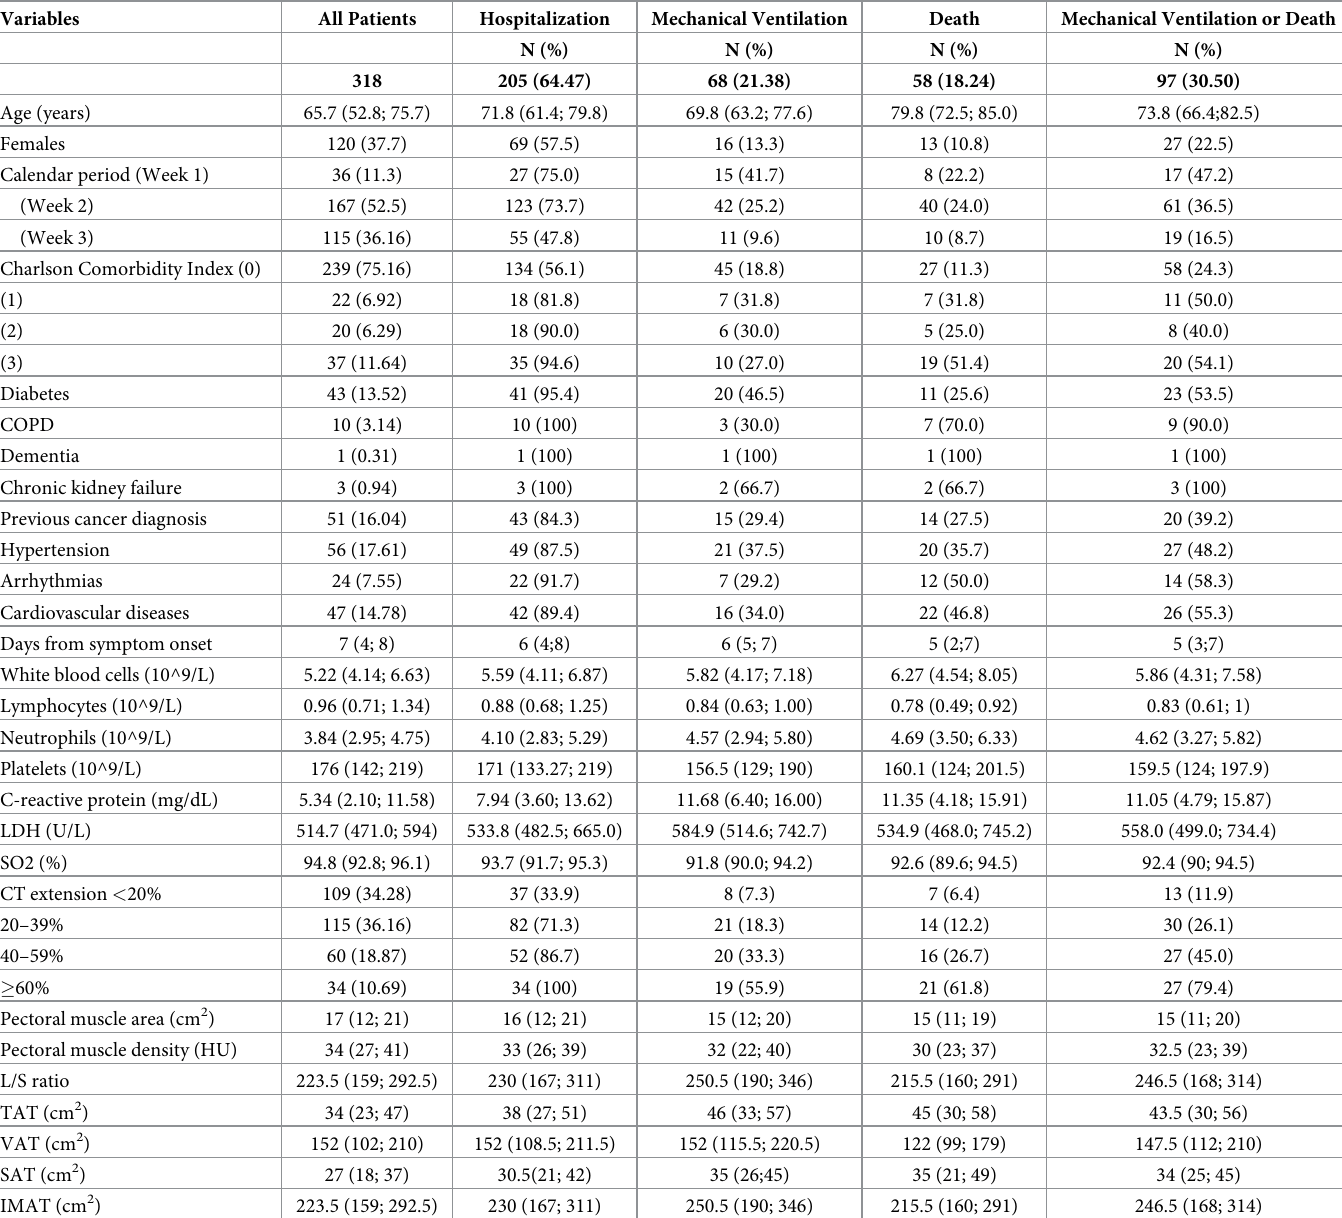
Table 1. Clinical and body composition parameters in the population as a whole and in patients experiencing different